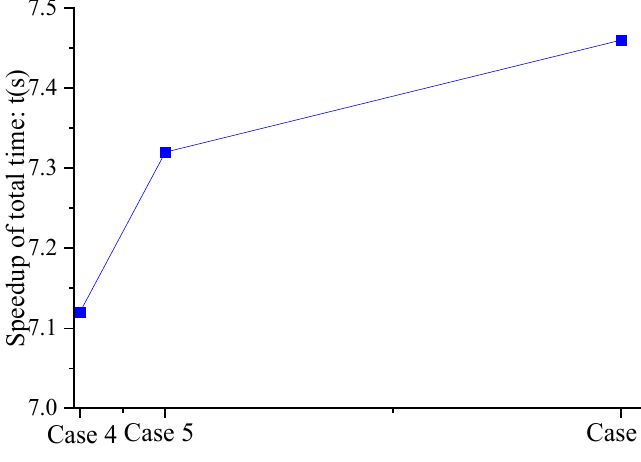
Figure 14. Speedup of total runtime for validation 2.